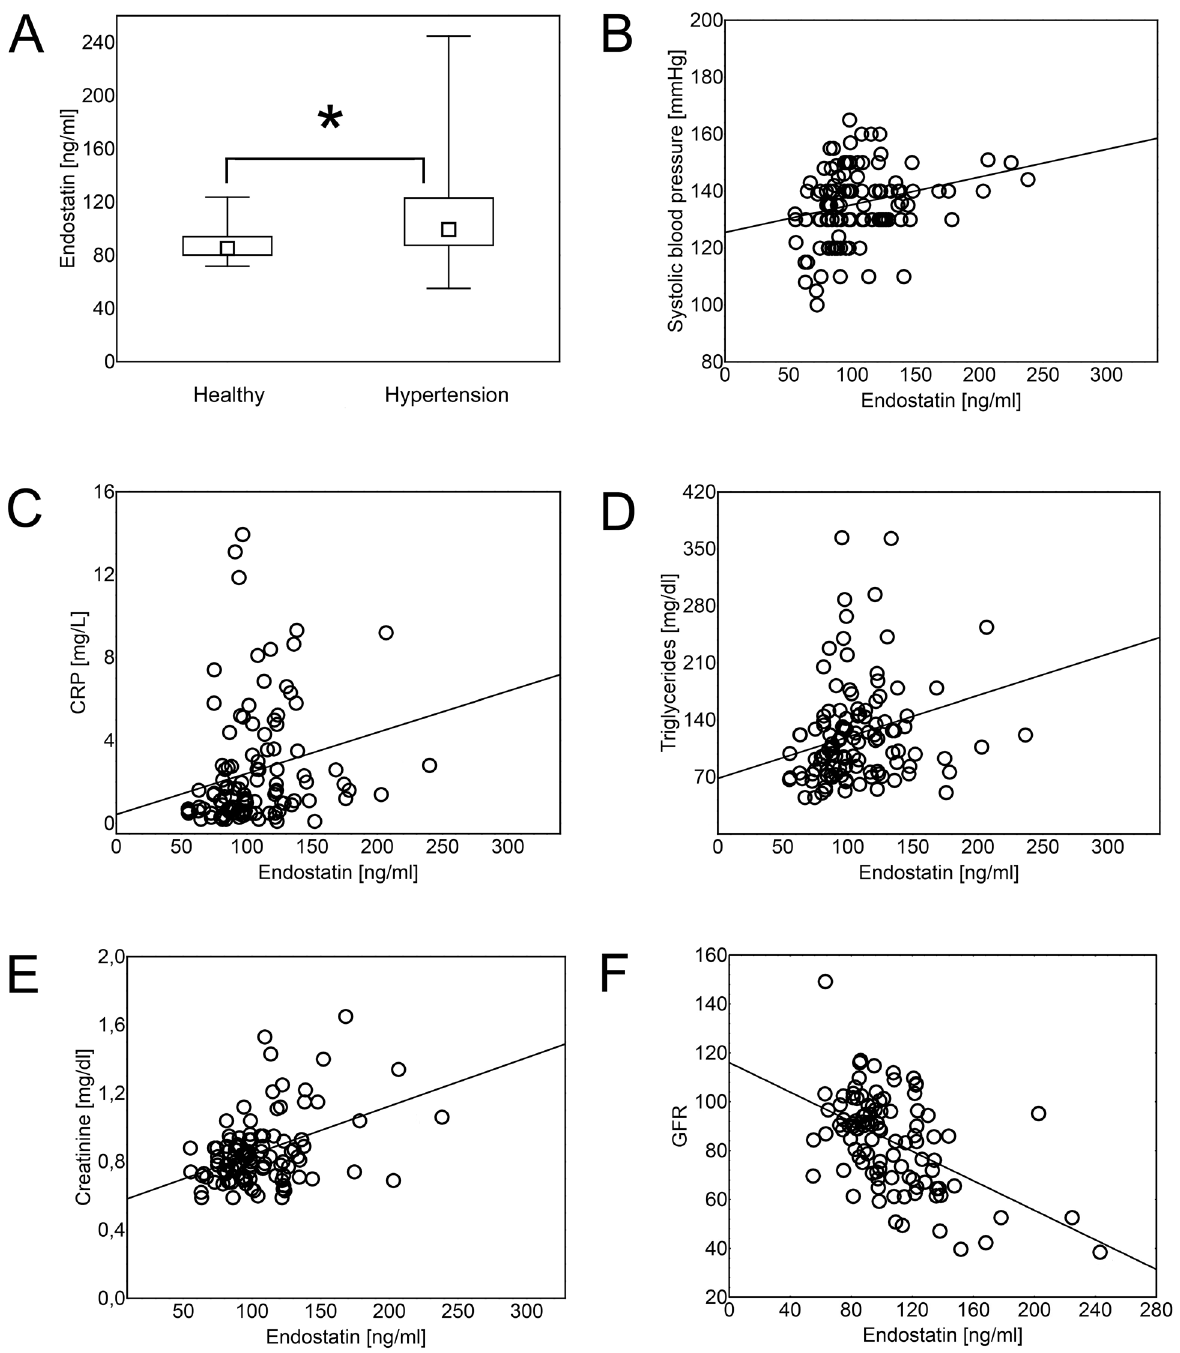
Fig 1. Endostatin concentration in hypertension. Hypertension was associated with increased serum levels of endostatin (Mann- Whitney U test; p = 8x10 -4 ). The data are presented as medians (symbols inside the boxes), 25 – 75% percentiles (boundaries of the boxes) and minimum — maximum (error bars outside the boxes). Statistical significance (p < 0.05) is marked with “ * ” (A). Endostatin concentration was in positive correlation (Spearman ’ s rank correlation) with systolic blood pressure (B; R = 0.287, p = 1x10 -3 ), CRP (C; R = 0,326,p = 4x10 -4 ), triglycerides (D; R = 0.260, p = 4x10 -3 ), serum creatinine (E; R = 0,313 p = 8x10 -4 ) and in negative correlation with glomerular filtration rate (GFR) (F; R = -0.42, p = 1x10 -5 ). Correlations were calculated for both- hypertensive and healthy individuals together.